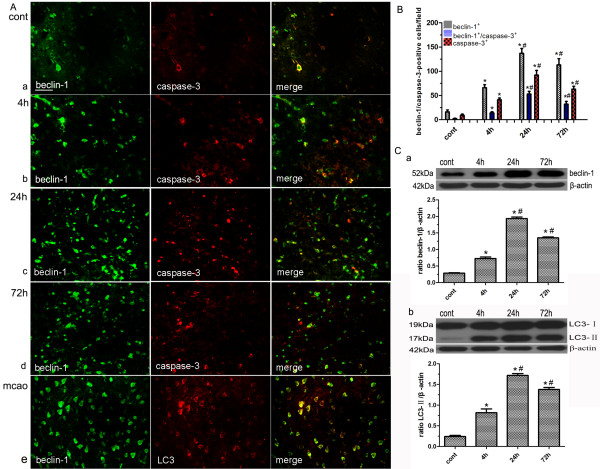
Upregulation of beclin-1 partly contributed to cell death. (A) Double immunostaining showed the co-localization of beclin-1 and caspase-3 in brains from the control (a) and MCAO group (4 h, 24 h, 72 h, b-d). Almost all cells with strong LC3 staining were labeled with beclin-1(e). (B) Quantification of beclin-1+, caspase-3+ and beclin-1+/caspase-3+ cells. (C) Western blot analysis of protein levels of beclin-1, LC3 and β-actin in the rat cortex and striatum derived from the control and MCAO group. Optical densities of respective protein bands were analyzed with Image J 1.42q and normalized to the loading control (β-actin). Results were expressed as mean ± SD from four independent experiments. *P < 0.001 vs. control group, #P < 0.001 vs. the previous time point. Cont: control group. Scale bars = 50 μm.